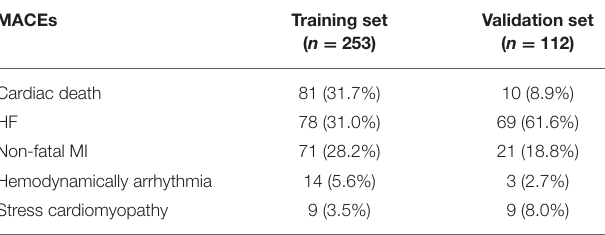
TABLE 2 | The proportion of MACEs in both training set and validation set.